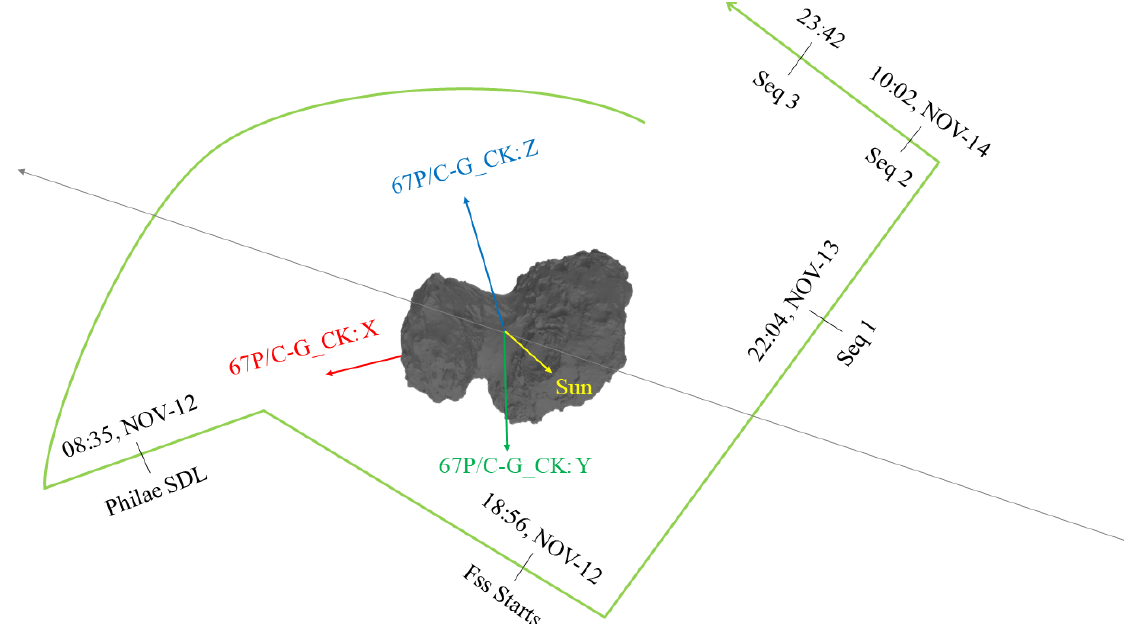
Figure 1. Rosetta trajectory during the Philae SDL phase (Separation, Descent and Landing) and FSS (First Science Sequence) phase. The Philae lander separated from Rosetta S/C at 08:35 UTC on 12 Nov 2014, and the CONSERT instrument operated through the descent of Philae until 14:51 UTC, then restarted at 18:56 UTC (FSS starts) [6]. Three sequences of direct visibility ranging data were collected during the FSS phase.